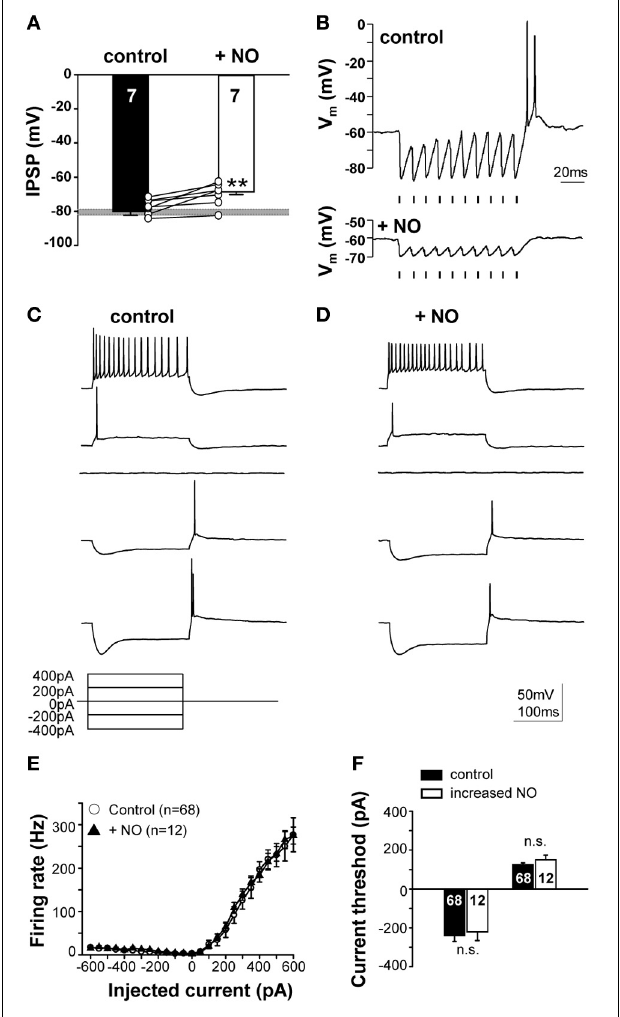
FIGURE 7 | Nitric oxide suppresses gap-detection on a cellular level. (A) Mouse SPN neurons show offset firing in responses to gaps of different durations (60–20ms) embedded in trains of electrically evoked IPSPs. (B) Bath application of an NO donor reduced the number of action potentials per gap and delayed the action potential within the gap so that only longer gaps were detected. Stimulus artifacts were removed for clarity. (C) The number of evoked action potentials increased with gap duration in controls (black bars), but was never more than one with NO (white bars). (D) Repetitive stimulation (10 IPSP trains) was used to estimate gap-detection success, which is plotted here as % offset action potentials against gap duration. Threshold was defined as 50% success (dashed line); controls (black) reliably detected gaps of 20ms or longer, but following NO, gap-detection thresholds increased to 60ms or longer. Data plotted as mean ± s.e.m. ( n indicated on the respective